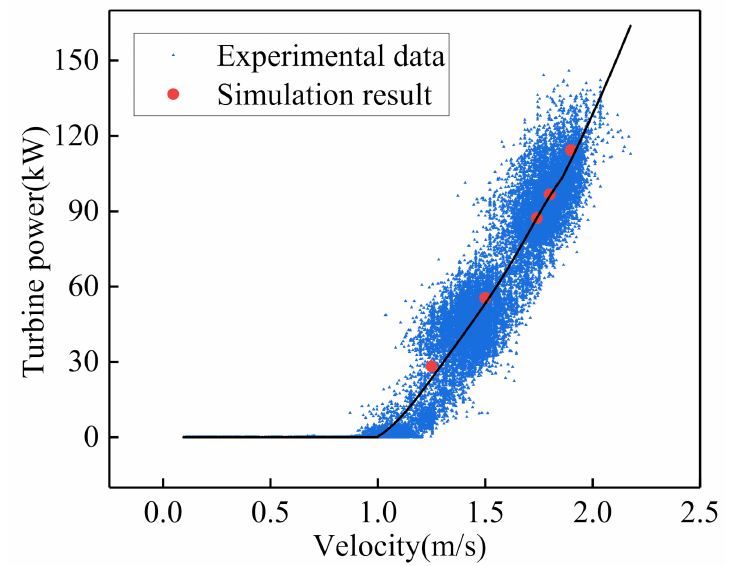
Figure 10. Comparison of the simulated turbine power with the experimental data at different flow